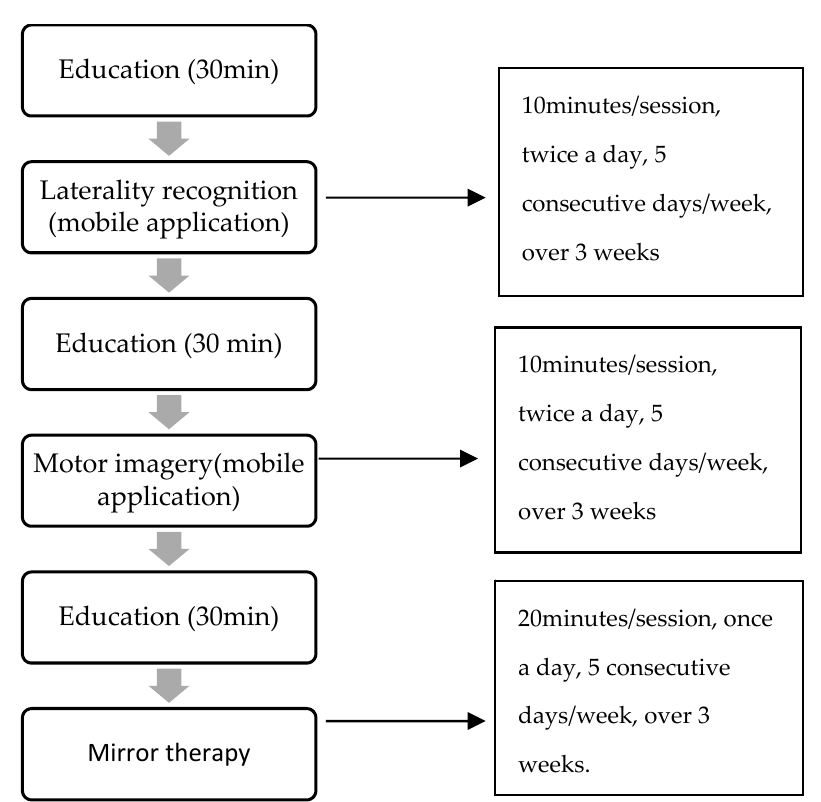
Figure 2. Sequence and progression of the intervention.